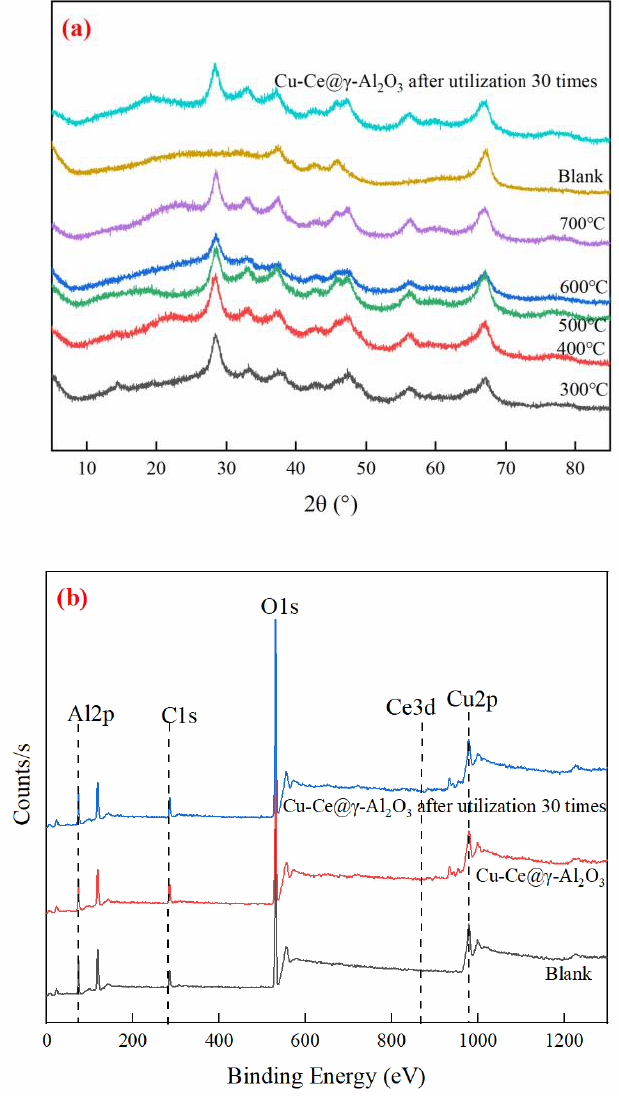
Figure 3. Characterization of the catalyst in different states: ( a ) XRD, ( b ) XPS.